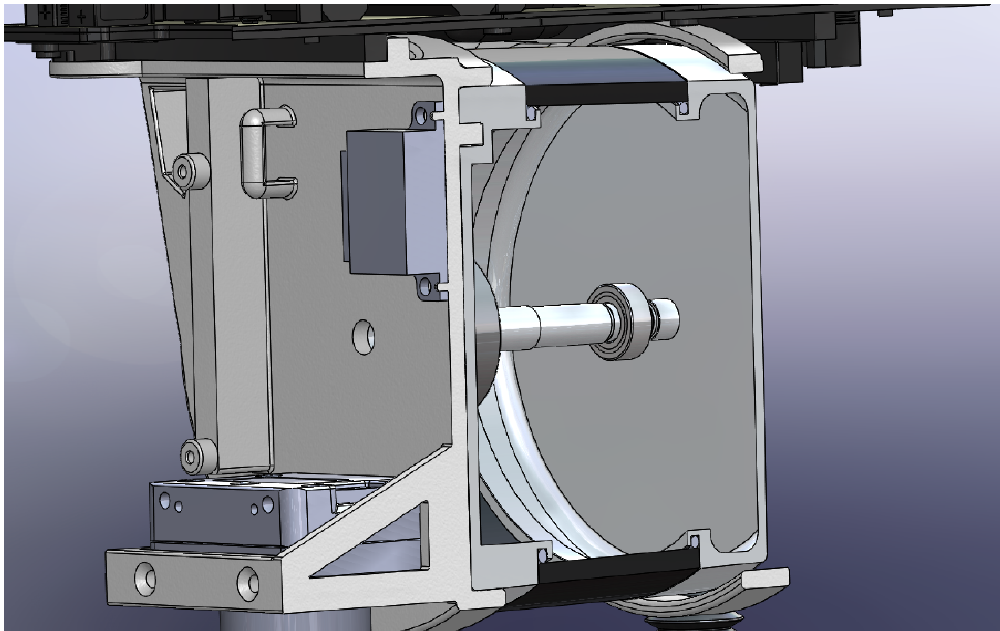
Figure A2. Image of the 3D CAD model of the sensor mount, designed to utilise the precision dowel pin holes in the LiDAR and